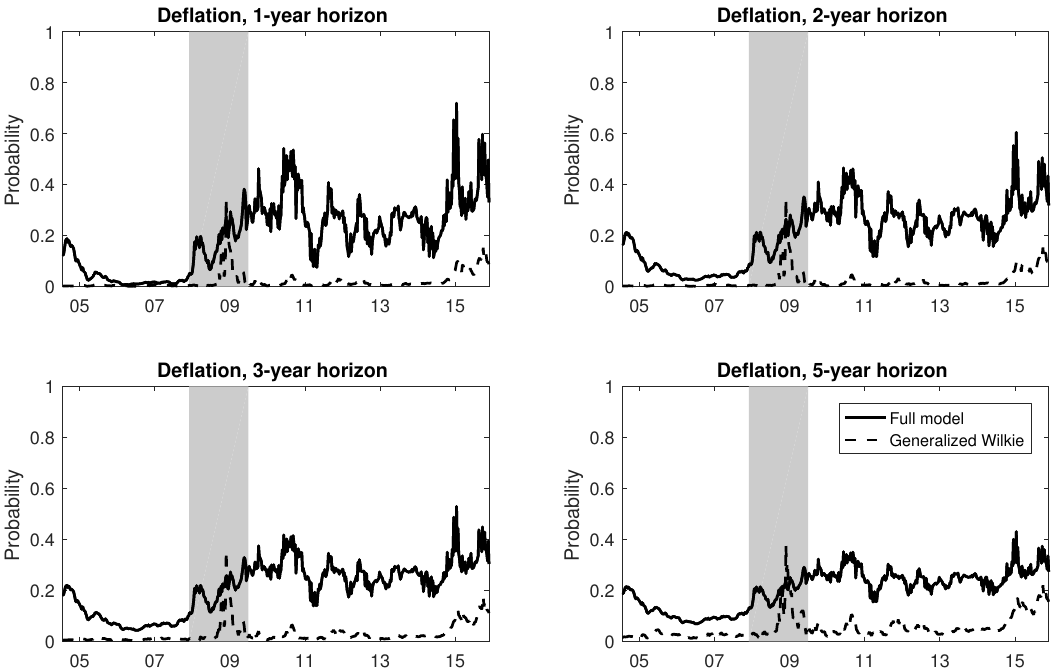
Figure 4. Probability of deflation for 1-, 2-, 3-, and 5-year horizons. Parameters of Table 4 and Panel C of Table 5 were used to filter the real inflation rate, the expected inflation rate, and the conditional variance. Then, the latent variables were utilized to compute time series of probabilities. Deflation corresponds to an annualized average inflation that is less than 0% for a given time horizon, under the physical measure P . The grey-shaded region highlights the NBER-dated